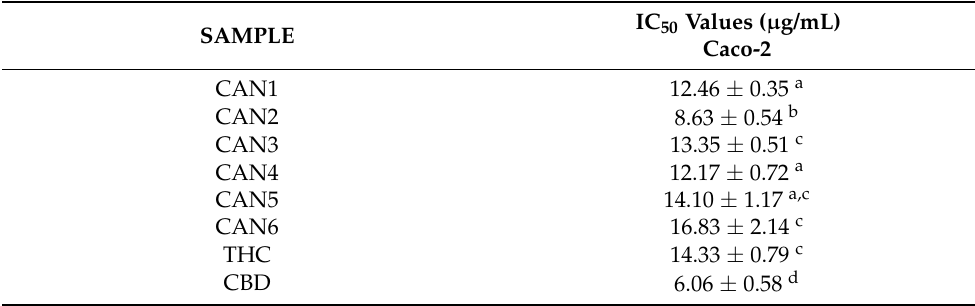
Table 4. Growth inhibition IC 50 values of Caco-2 cells for Cannabis extracts and isolates after 48 h (mean ± S.D). Same superscript letters in the table denote no statistical difference and different letters refer to statistically significant difference between results. Full data evaluating statistically significant differences between the samples are shown in Supplementary Materials, Table S6.